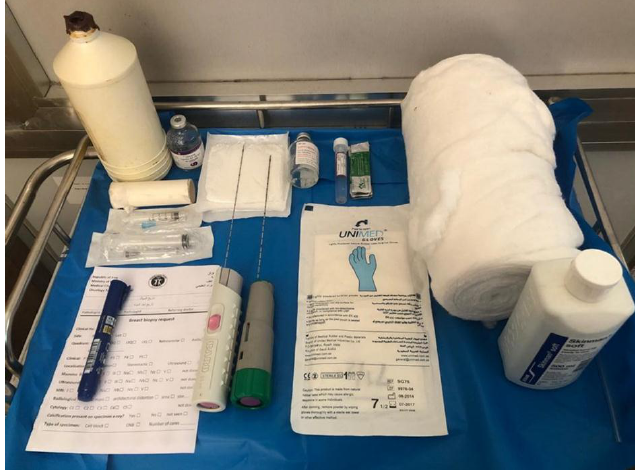
Figure 1 The side tray for core needle biopsy taking When the patient had taken the right position, the plane